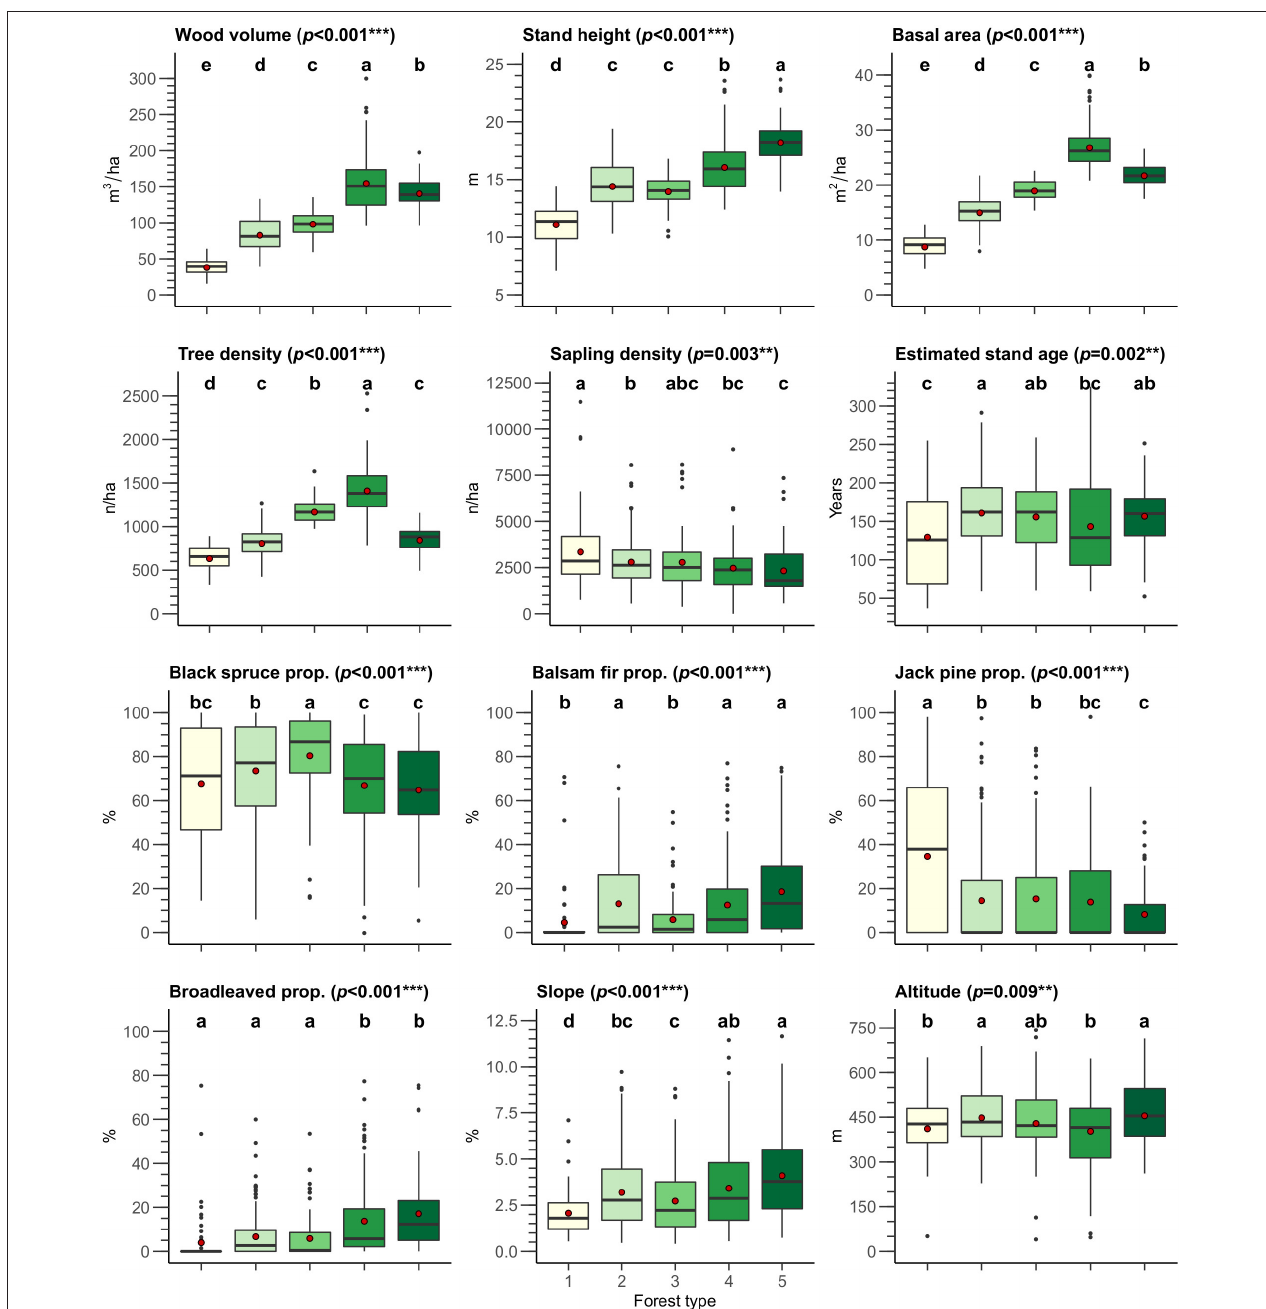
FIGURE 5 | Boxplot of the transect attributes by forest type. Red dots represent mean values. PERMANOVA p -value for each transect attribute are shown in brackets. On each panel, lowercase letters (a–e) above boxplots indicate if forest types are significantly different according to the pairwise PERMANOVA comparison. Two forest types are significantly different when they show different lowercase letters. Prop., proportion; p , p -values of the PERMANOVA test; “*” indicates p < 0.05, “**” p < 0.01, and “***” p < 0.001. Details of the PERMANOVA tests are provided in Appendix B and details of the pairwise PERMANOVA comparisons in Appendix C